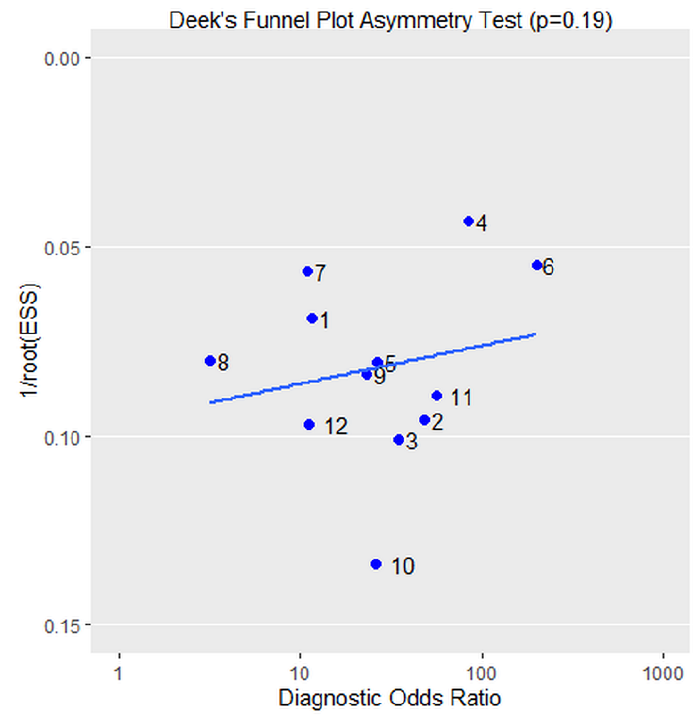
Figure 5 . Deek’s funnel plot. The regression test showed no significant publication bias ( p =